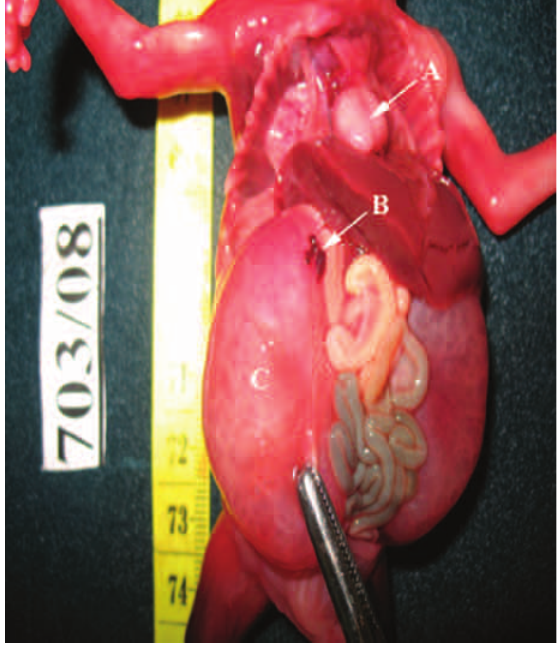
Figure 2. Dextrocardia, polysplenia, nephromegaly. A – Dextrocar- dia; B – Polysplenia; C – Nephromegaly